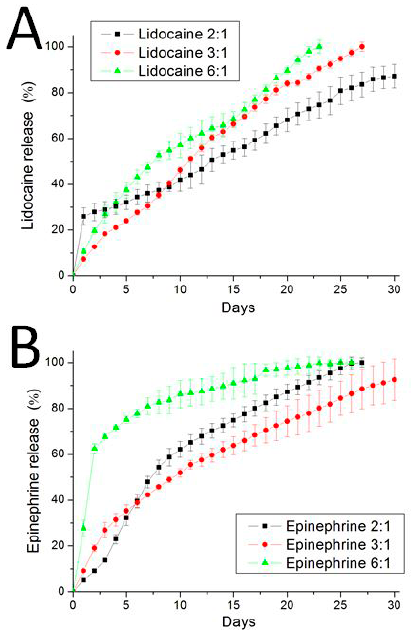
Figure 5. Release curves of: ( A ) lidocaine; and ( B ) epinephrine from the nanofibrous membranes. All biodegradable nanofibers released effective concentrations of epinephrine and lidocaine for over three weeks.